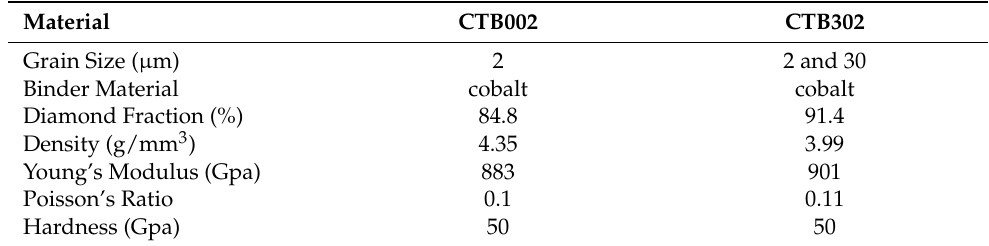
Table 1. Basic physical properties of polycrystalline diamond (PCD) tool materials [28].